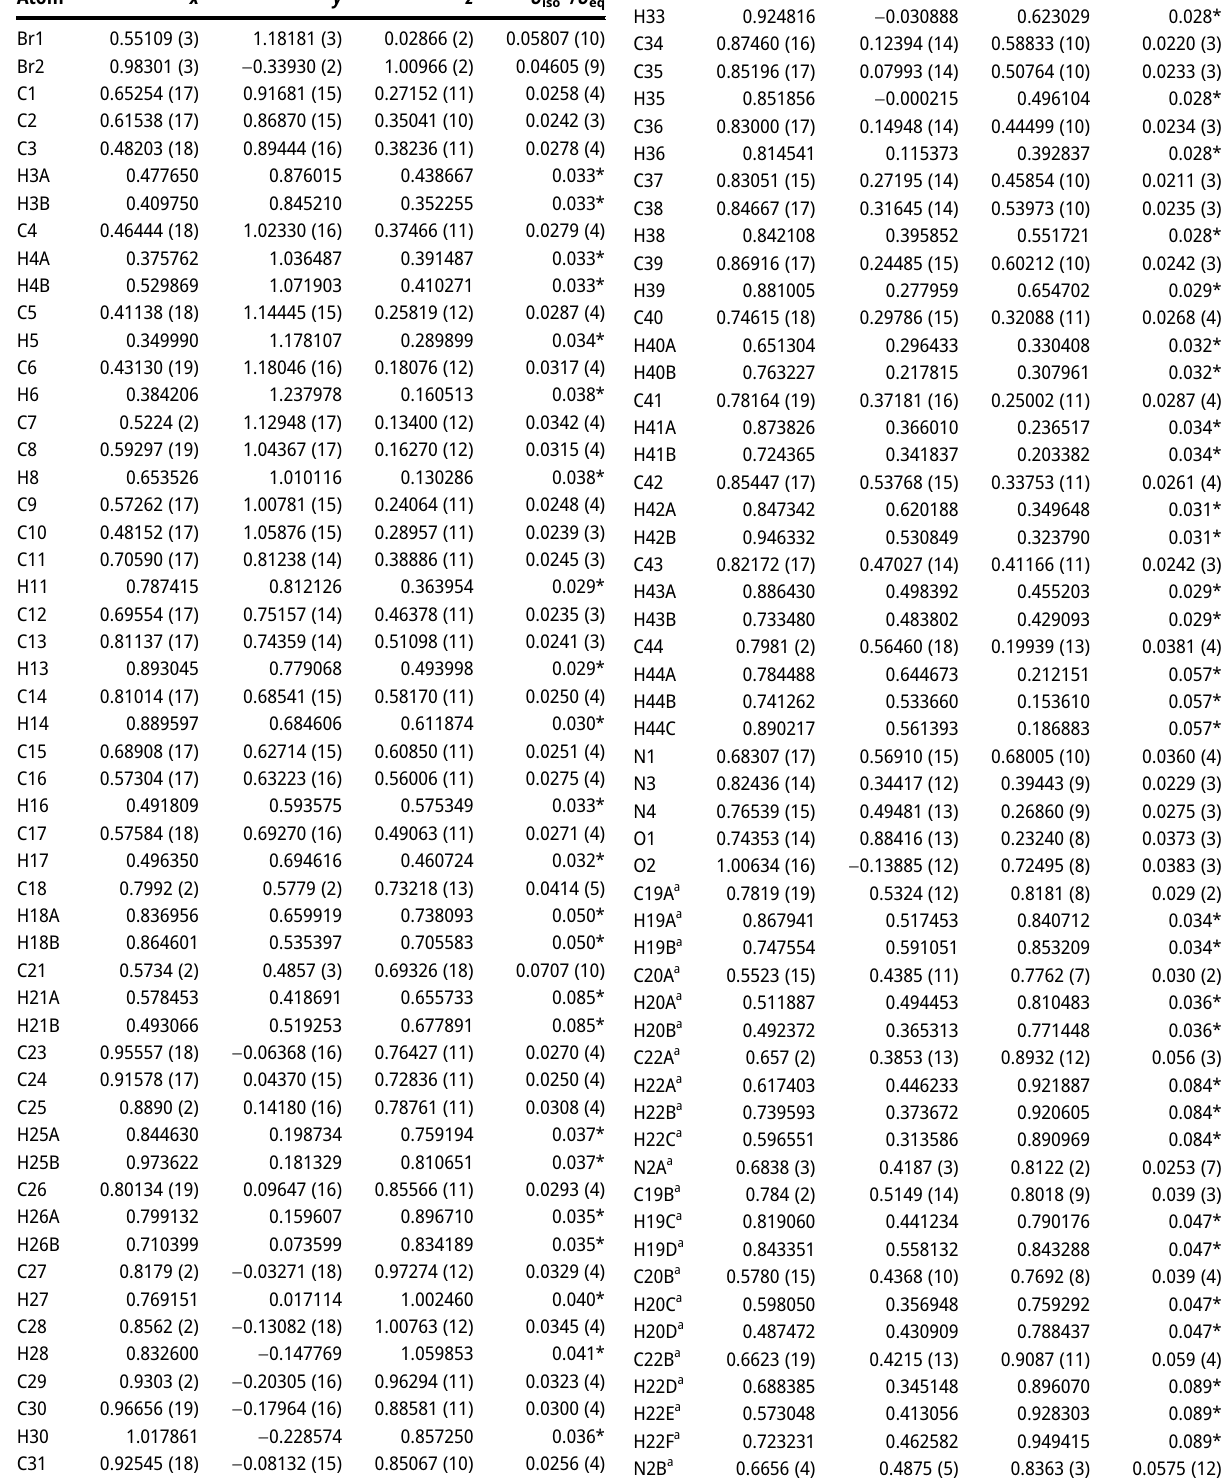
Table  : Fractional atomic coordinates and isotropic or equivalent isotropic displacement parameters (Å 